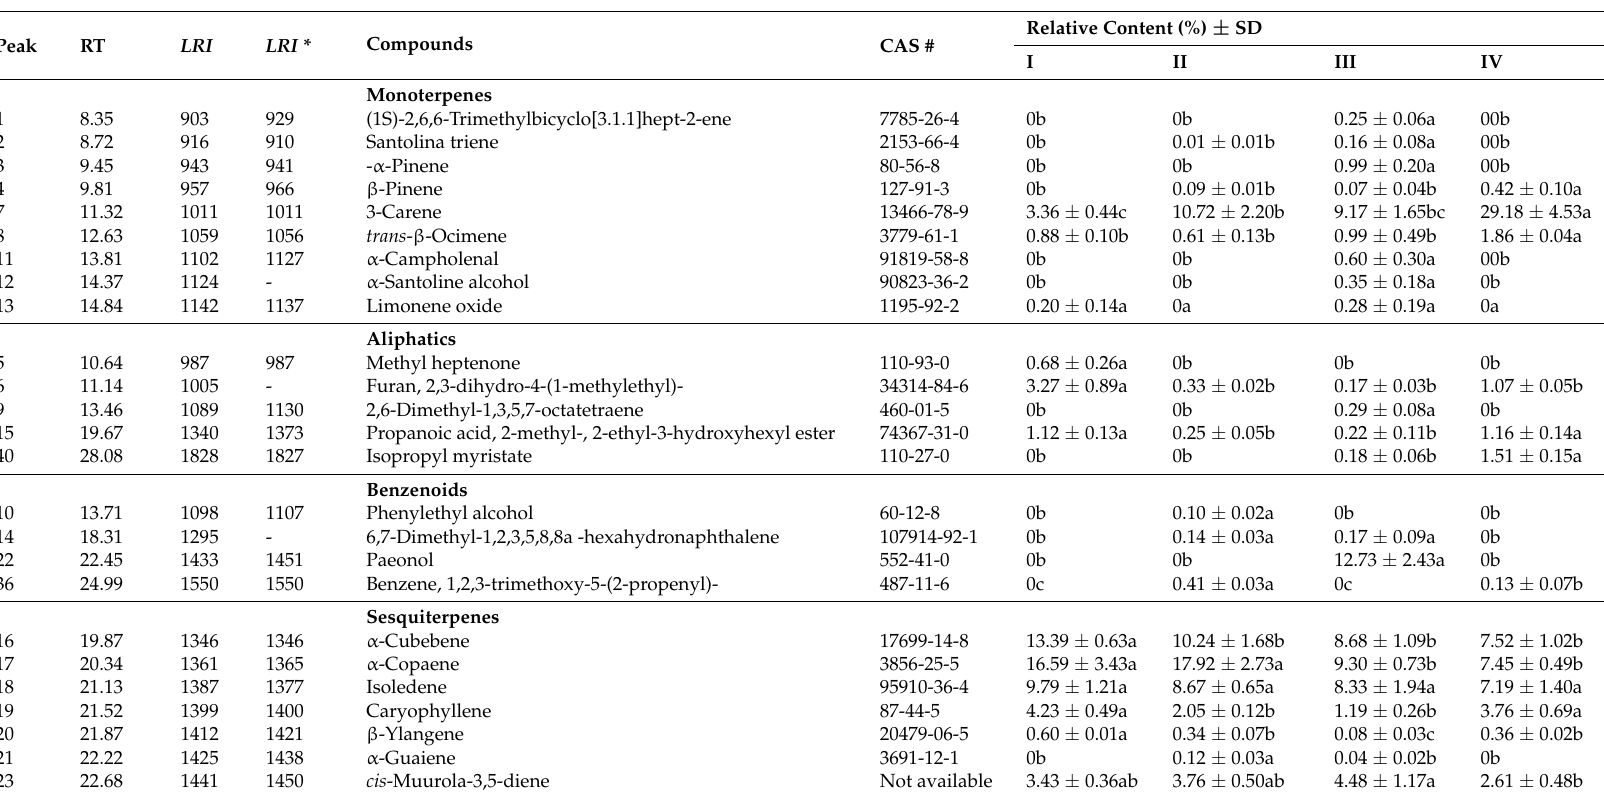
Table 1. Volatile compounds identified in four different stages of L. yunnanensis flower development using headspace solid phase micro-extraction (HS-SPME) coupled with gas-chromatography mass-spectrometry (GC-MS) (HS-SPME-GC-MS). (I) bud stage; (II) initial-flowering stage; (III) full-flowering stage; and (IV) end-flower